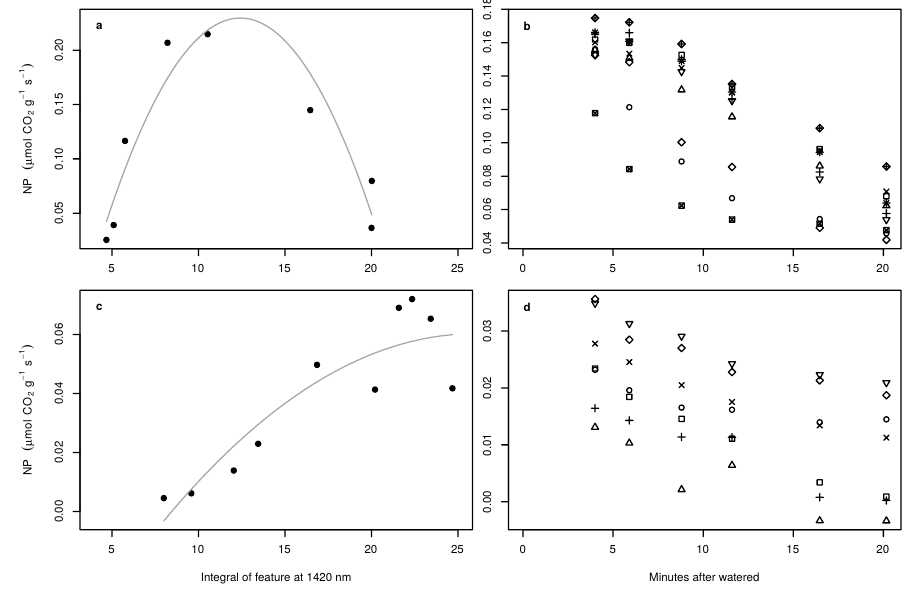
Figure 8. Relationship between NP of Acarospora cf. gypsi-deserti and the integral of the absorption feature at 1420 nm ( a ). The grey curve symbolizes the regression of the polynomial fit. Predicted NP of Acarospora cf. gypsi-deserti in the field in relation to the time passed since being watered ( b ). Symbols in ( b ) indicate individuals. Note that time is always the end time of the scan process, which took about 11 s for the entire image. ( c , d ) show the same, but for Caloplaca santessoniana